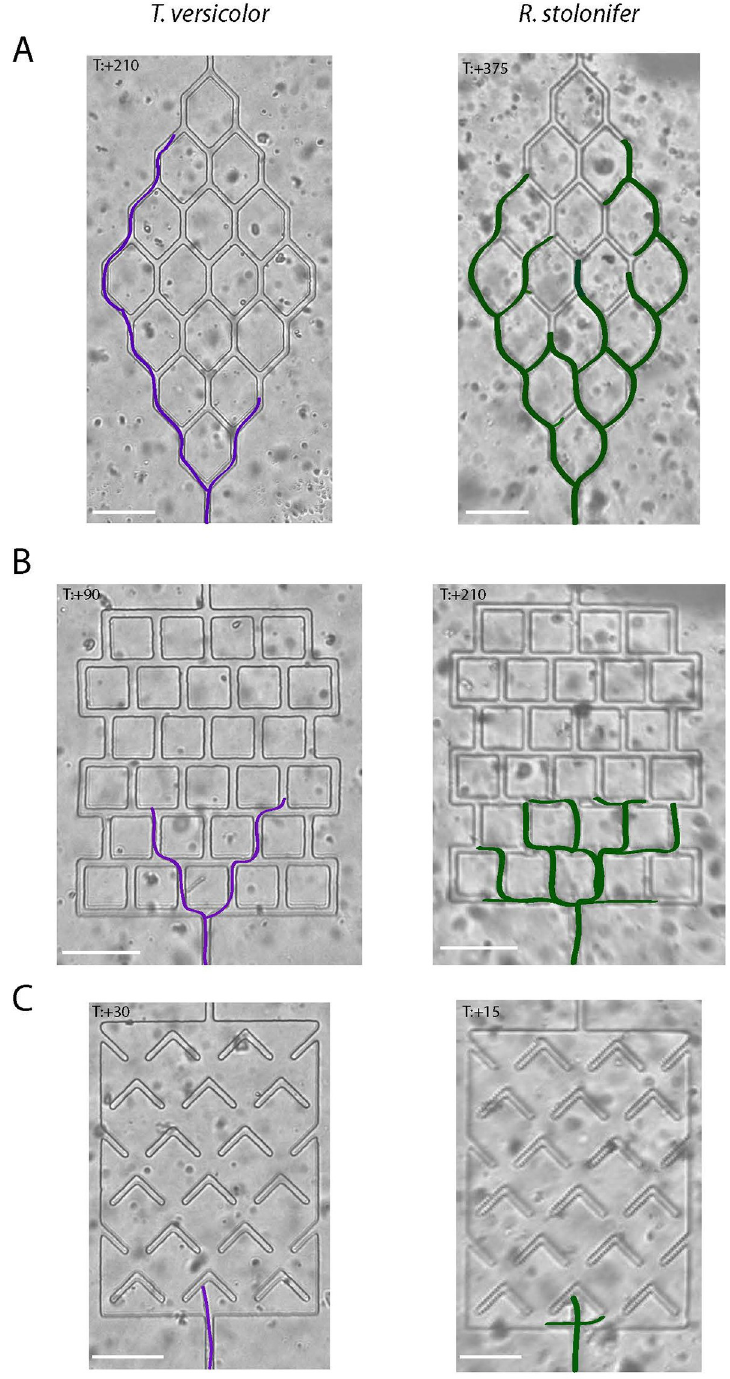
Fig 4. Growth strategies. T . versicolor and R . stolonifer use different growth strategies for navigating different mazes. T . versicolor establishes a dominant branch that grows faster. R . stolonifer branches often; however, each branch grows slower. T . versicolor strategy appears to be more efficient in devices with simple challenges, like the bifurcating channels. R . stolonifer branching strategy is an advantage when confronting complex challenges, like the boomerang traps. Scale bars are 100 μ m. To make growth patterns more easily visible, T . versicolor hyphae were traced in purple and R . stolonifer hyphae were traced in